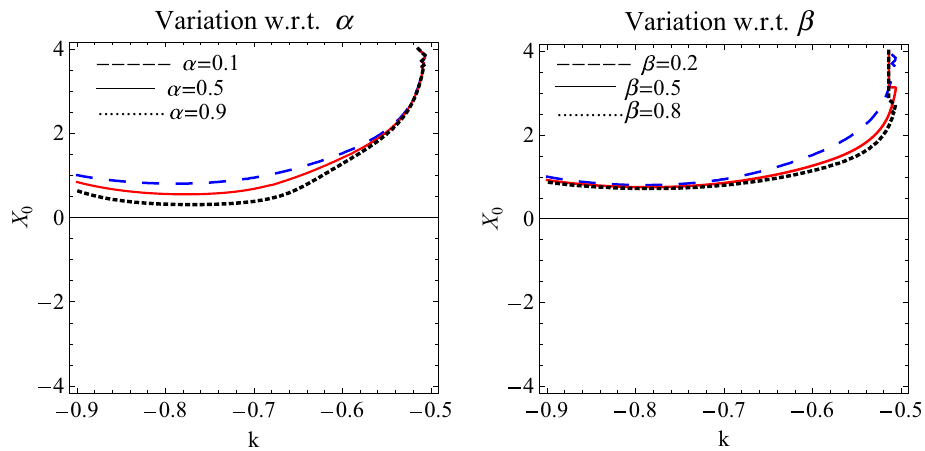
at β = 0 . 2, γ = 5, V 0 = 0 . 1, ω = − 0 . 5, η = 1, E 1 = 1 . 42 × 10 − 13 , E p = 1 . 221 × 10 19 . In Fig. 2 the other parameters are taken as α = 0 . 1, γ = 5, V = 0 . 1, ω = − 0 . 5, η = 1, E = 1 . 42 × 10 − 13 , 0 1 E p = 1 . 221 × 10 19